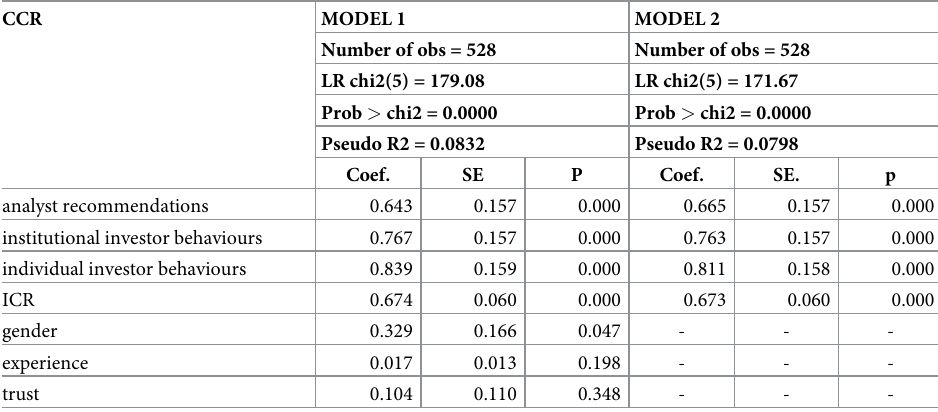
Table 2. The perception of collective corporate reputation.